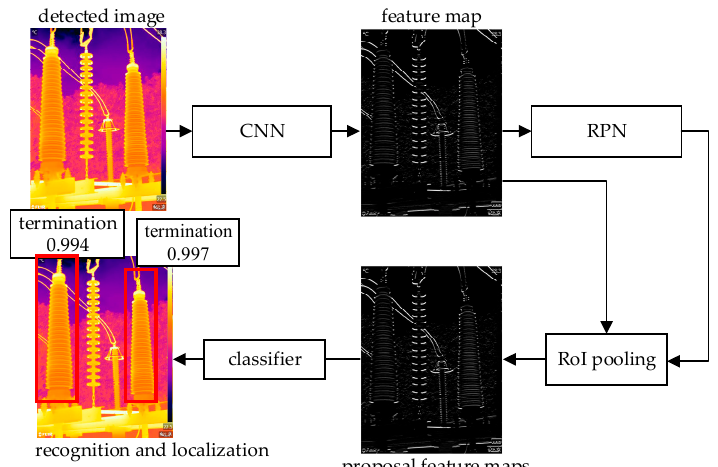
Figure 1. Model of Faster RCNN network.